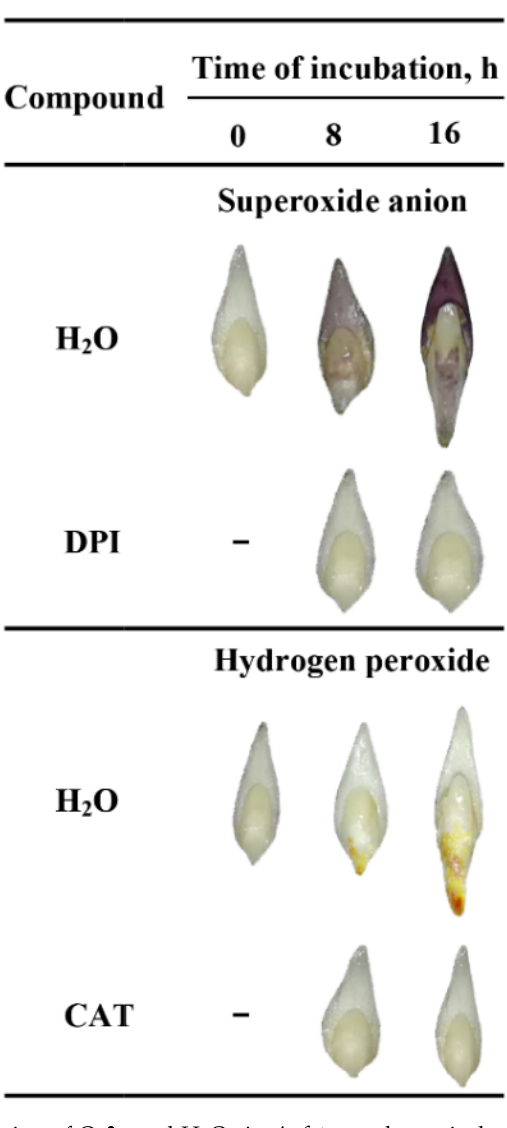
Figure 2. In situ localization of O 2• − and H 2 O 2 in A. fatua embryos isolated from seeds incubated in water, DPI (10 − 4 M) or CAT (1000 U) at 20 °C for different time. Representative stained embryos are shown.